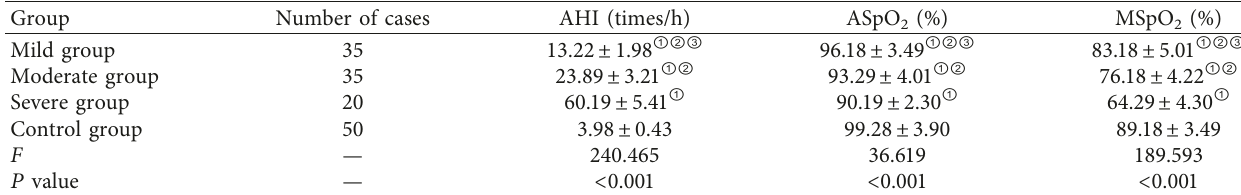
Table 5: Comparison of PSG-related indicators among patients in each group ( x ± s ).